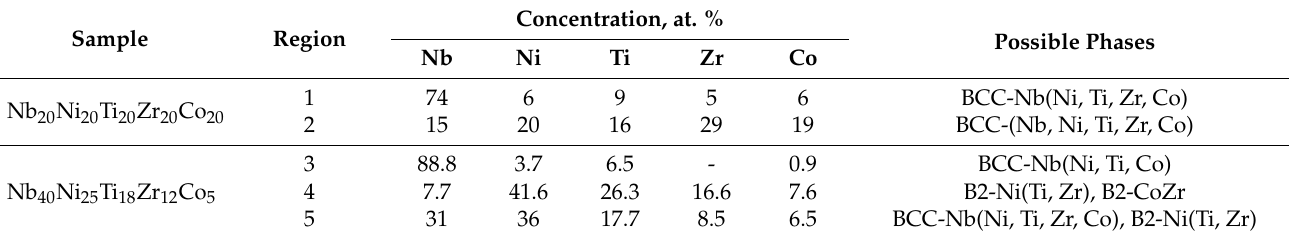
Table 1. Elemental concentration in different regions as depicted in Figure 3.